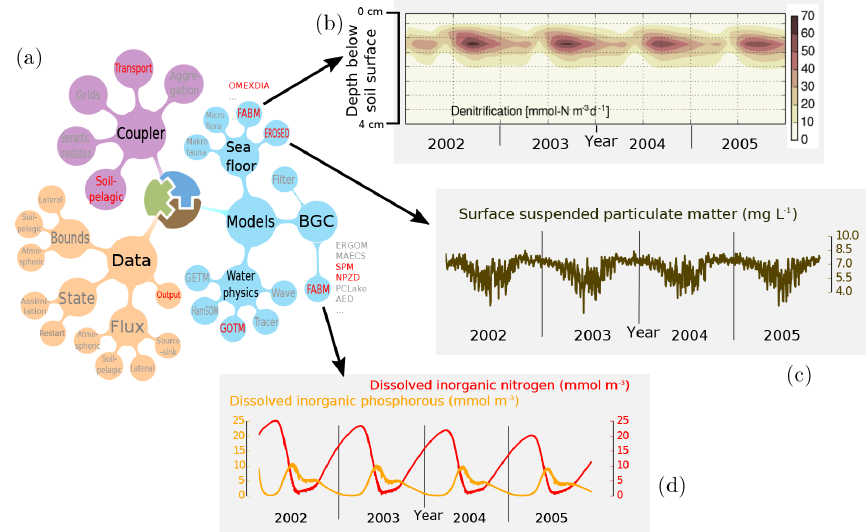
Figure 5. Coupling set-up and exemplary results from a 1-D system simulating the nutrient and SPM dynamics near the island of Helgoland, Germany with soil–pelagic coupling from 2002 to 2005. (a) Coupling set-up with seven ESMF components (highlighted in red, leaves) and three FABM sub-models (side text); (b) soil denitrification rate; (c) surface SPM dynamics resulting from EROSED and pelagic FABM–SPM; (d) middle water column nitrogen and phosphorous dynamics from pelagic